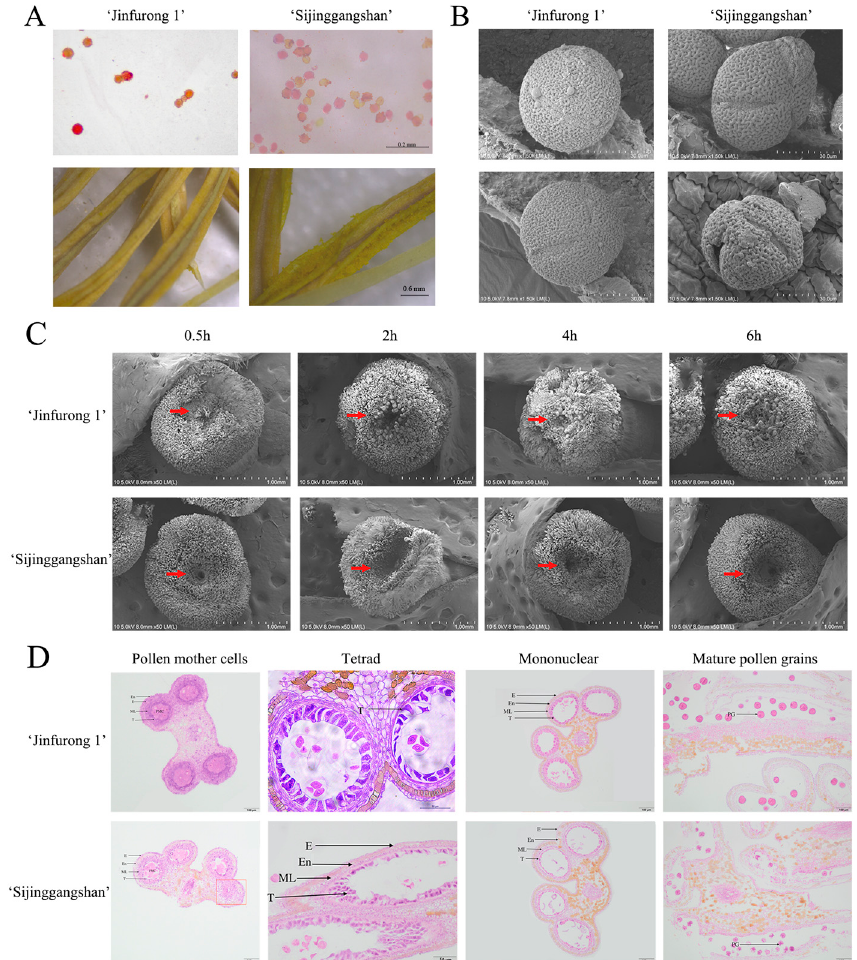
Figure 2. Comparison of pollen development of ‘Jinfurong 1’ and ‘Sijinggangshan’. ( A ) Pollen grain staining and powder dispersion of ‘Sijinggangshan’ and ‘Jinfurong 1’. ( B ) Pollen grain morphology of ‘Jinfurong 1’ and ‘Sijinggangshan’. ( C ) Pollen grain germination of ‘Sijinggangshan’ and ‘Jinfurong 1’ on stigma after artificial pollination. The stigma of the two cultivars was selected for observation at 0.5, 2, 4 and 6 h after artificial pollination. The red arrow points to the anther development of the stigma mouth. ( D ) Another development of ‘Jinfurong 1’ and ‘Sijinggangshan’. E, Epidermal layer; ML, middle layer; En, endothecium; T, tapetum; PMC, pollen mother